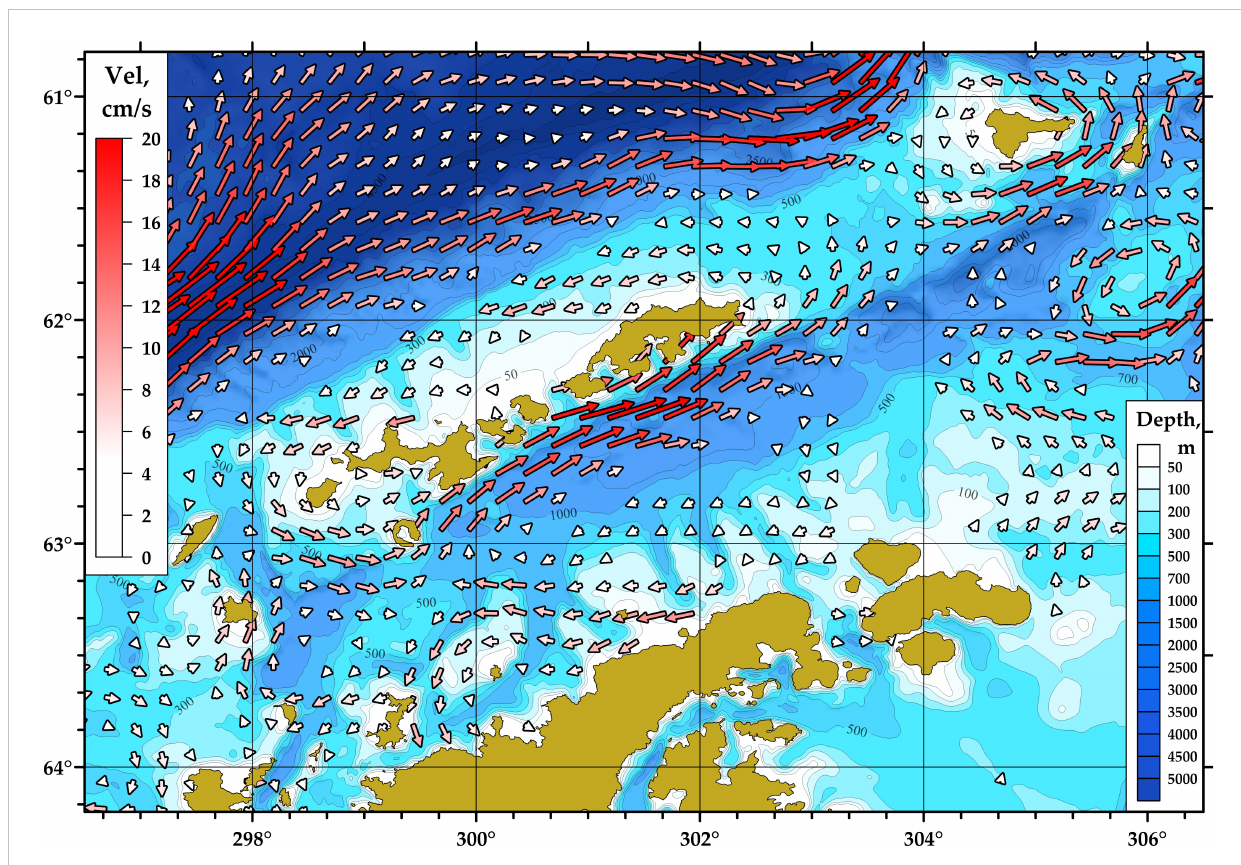
FIGURE 12 Mean geostrophic circulation in the region of the Brans fi eld Strait based on geostrophic velocities derived from the MDT data. Velocity magnitude is shown by colored arrows only for the mean speeds exceeding 3